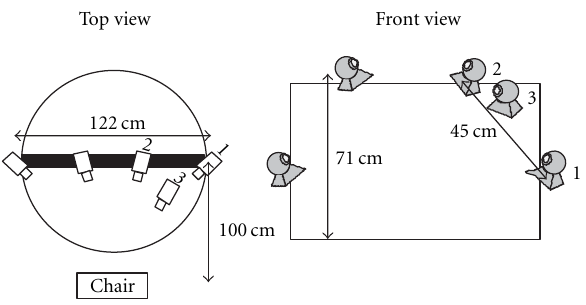
Figure 13: Setup with rotate cameras for the experiments in Figure 14. The advantage of this configuration is that the rectified stereo views may get smaller dimensions to ease the memory access